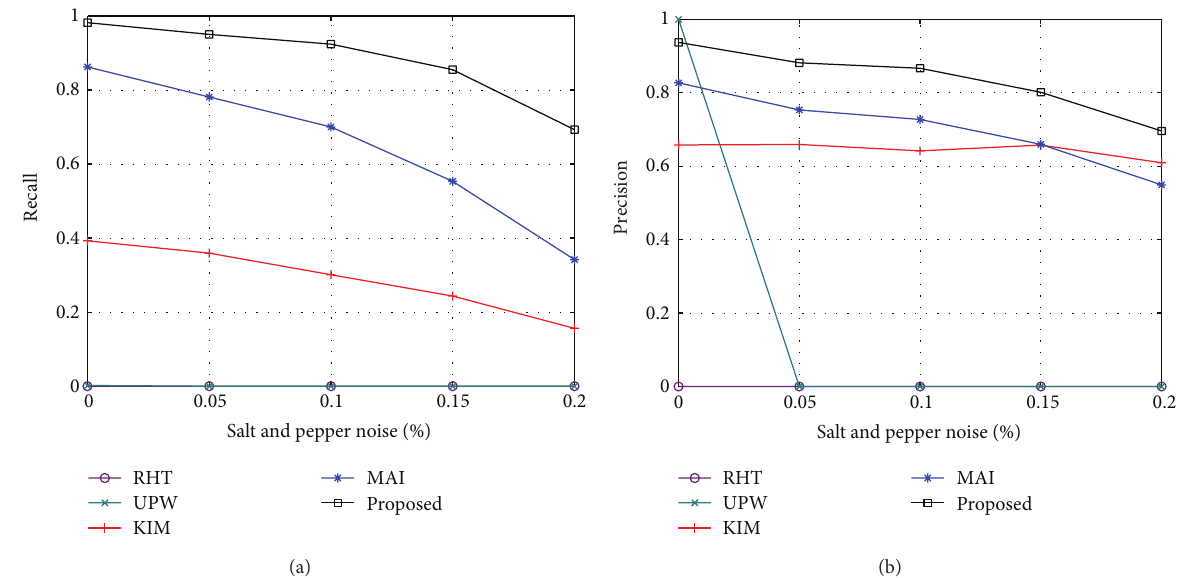
Figure 11: Recall and precision of each method for different ratios of salt and pepper noise. (a) Recall. (b) Precision.